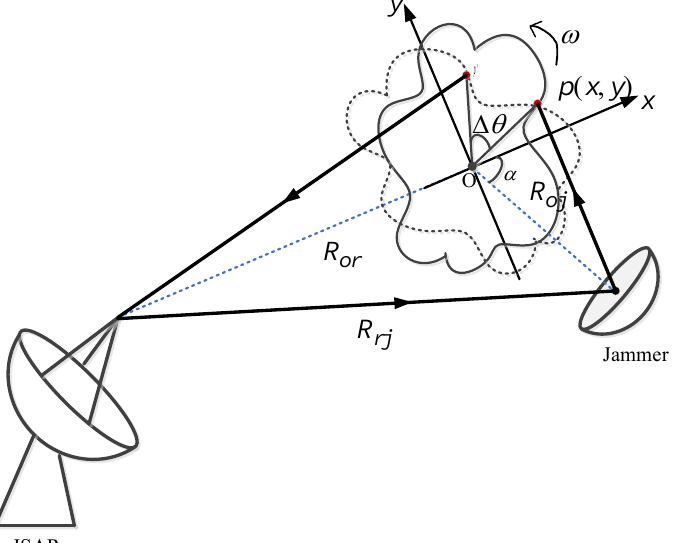
Figure 1. The geometry of the jamming configuration.